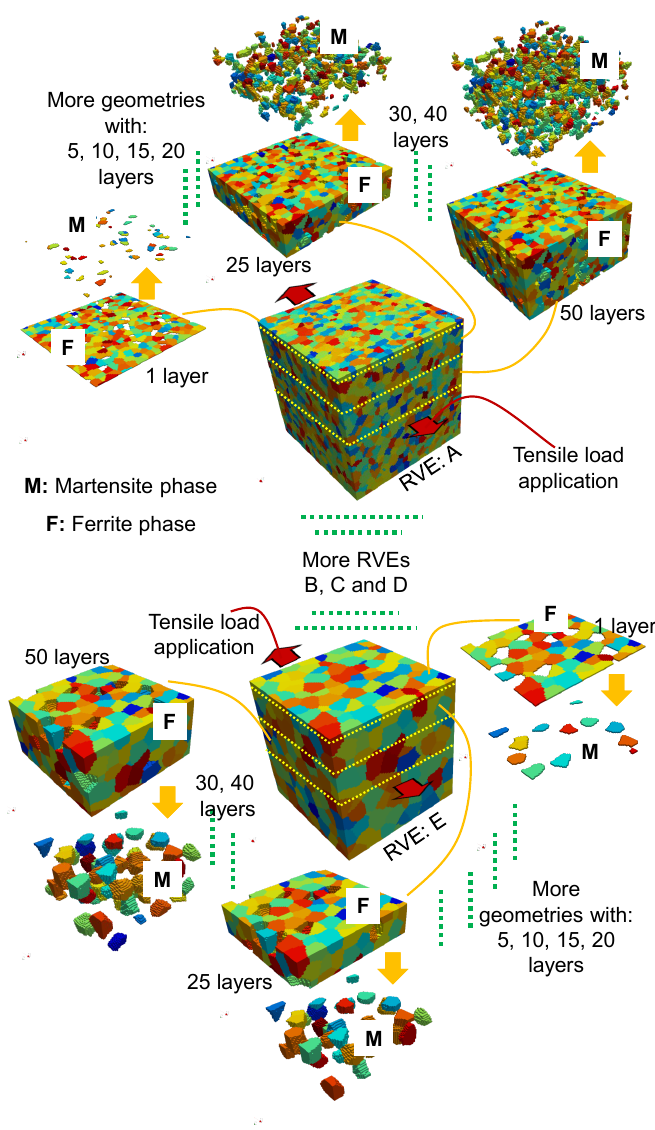
Figure 2. Schematic diagram representing the generated 3D RVEs and their slicing sequence for the construction of simulation geometries. RVE-A and E are shown in this figure, whereas B, C, and D were modeled similarly. The slicing sequence is also shown in the figure with a yellow dotted line, and green dotted lines represent more sliced geometries that are not shown here but were constructed for simulations. Ferrite (F) and Martensite (M) are shown separately in the sliced images for better visualization of phase distribution in the